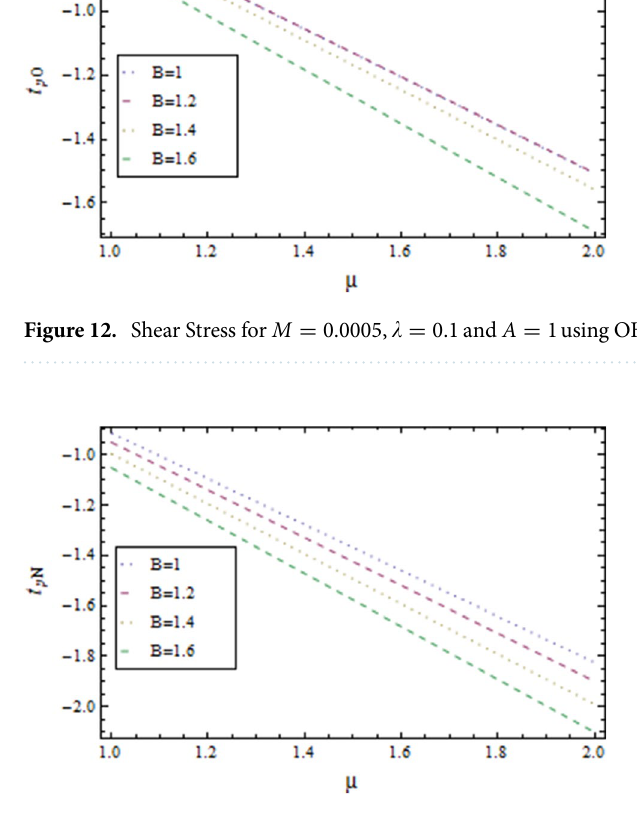
Figure 13. Shear Stress for M = 0.0005, (cid:31) = 0.1and A = 1 using